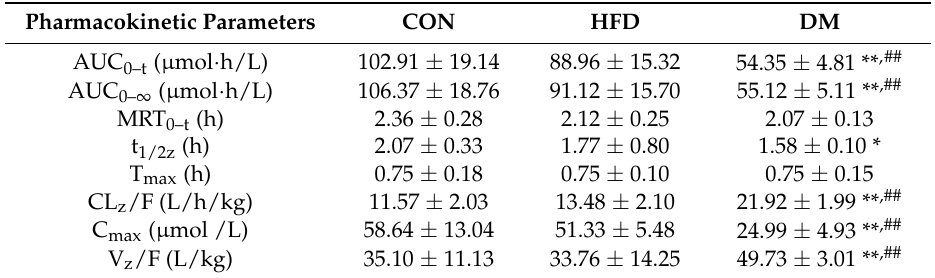
Table 5. Pharmacokinetic parameters of puerarin after its oral administration (500 mg/kg, approximately 120 µ mol/kg) to DM, HFD, and CON rats.